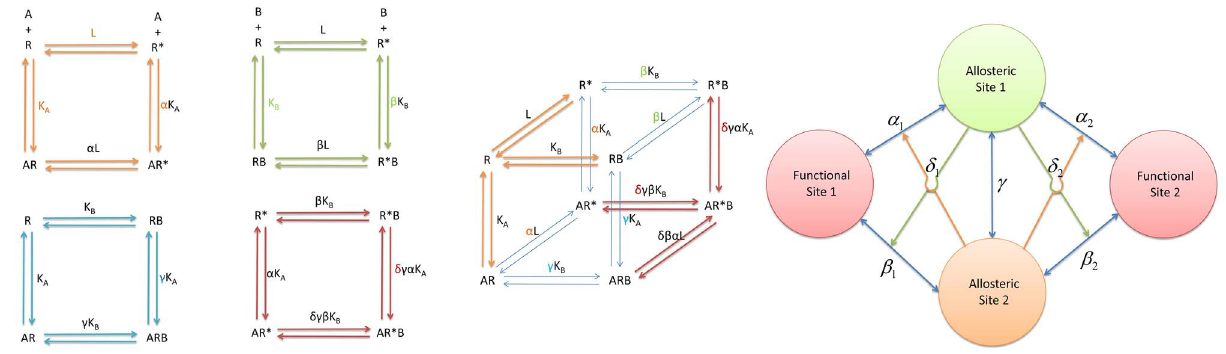
Figure 6. The extended ATSM with two allosteric ligands. (A) The model has ten species related by four equilibrium cycles with seven parameters. The first equilibrium cycle (orange) specified by the L , K A , and a is exactly the same as in the simplest ATSM (Figure 2A), giving L the equilibrium constant between the two states, K A the binding affinity of ligand A bound to inactive R , and a the allosteric intrinsic efficacy of ligand A . The second equilibrium cycle R (cid:2) B / RB / R ? R (cid:2) ? R (cid:2) B (pale green) describes the second ligand binding similar to the first ligand binding, assigning K B and b respectively as the binding affinity and the allosteric intrinsic efficacy of ligand B . In the third equilibrium cycle ARB / AR / R ? RB ? ARB (cyan), the sixth parameter c administers the binding cooperativity between ligand A and B upon the formation of the ternary complex ARB . Similarly, the seventh parameter d governs the activation cooperativity between ligand A and B through the formation of AR (cid:2) B in the fourth equilibrium cycle AR (cid:2) B / AR (cid:2) / R (cid:2) ? R (cid:2) B ? AR (cid:2) B (red). (B) The complete equilibrium cycles of the extended ATSM. The four essential equilibrium cycles of the extended ATSM in (A) are combined into a cubic shape of a complete cycle. To guide the visualization, the two corners of the complete cycle are highlighted by colored equilibrium arrows for species R and AR (cid:2) B and colored parameters for referencing back to the individual essential equilibrium cycle. (C) The structural view of allostery with two allosteric site and two (independent) functional sites. The drawing is based on two assumptions. First, the populations of the two functional sites are regulated independently by two distinct allosteric sites. Second, the two functional conformations coexist. The allosteric coupling set ( a 1 , b 1 , and d 1 ) for functional site 1 and a duplicated set of independent allosteric efficacies ( a 2 , b 2 , and d 2 ) for functional site 2 are similar to the description in Figure 6B. These two sets of coupling are linked by a shared binding cooperativity c , coupling the two allosteric sites.